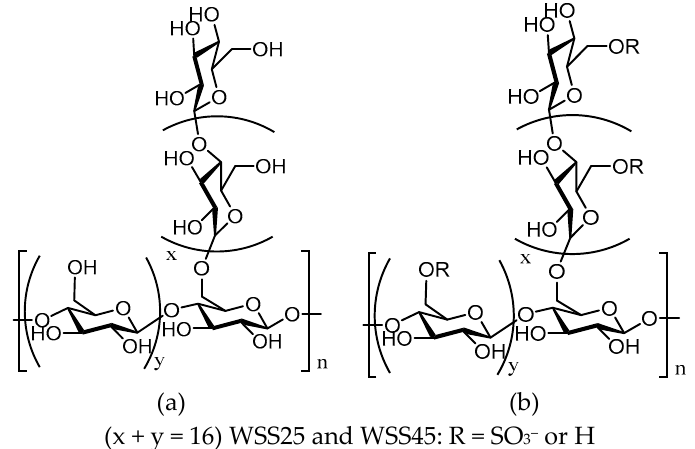
Figure 2. Structures of WGEW ( a ) and its sulfated derivatives WSS25 and WSS45 ( b ) [4] At the same time, the antiviral activity structure-activity relationship of sulfated polysaccharides is very complex. It is not enough to depend on only four sulfated polysaccharides to